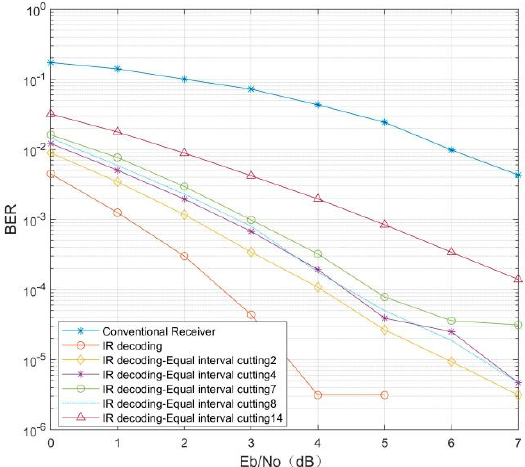
Figure 12. Intelligent receiver performance under different cropped data in Rayleigh channel.